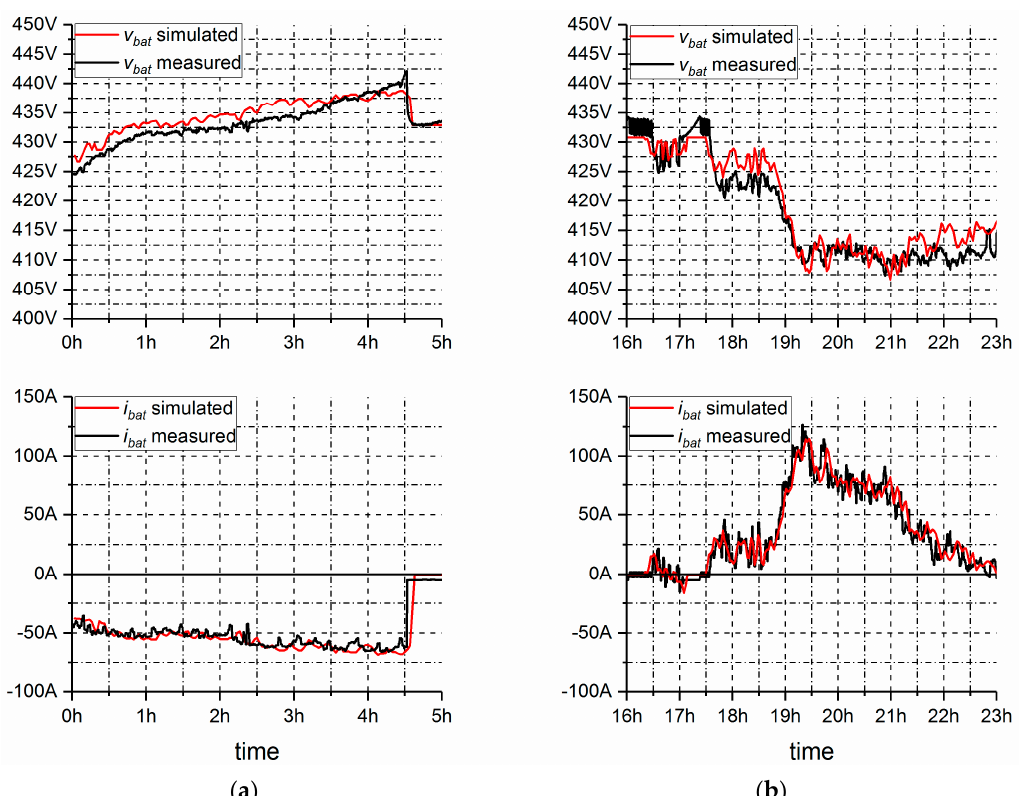
Figure 20. Simulation and measurement results for Shepherd’s model ( a ) charging and ( b ) discharge.